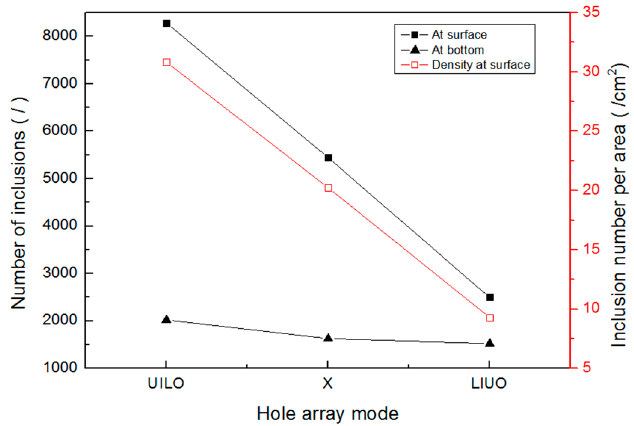
Figure 12. Comparison of the obtained number of inclusions at the molten steel surface between the MHDBs in different modes.